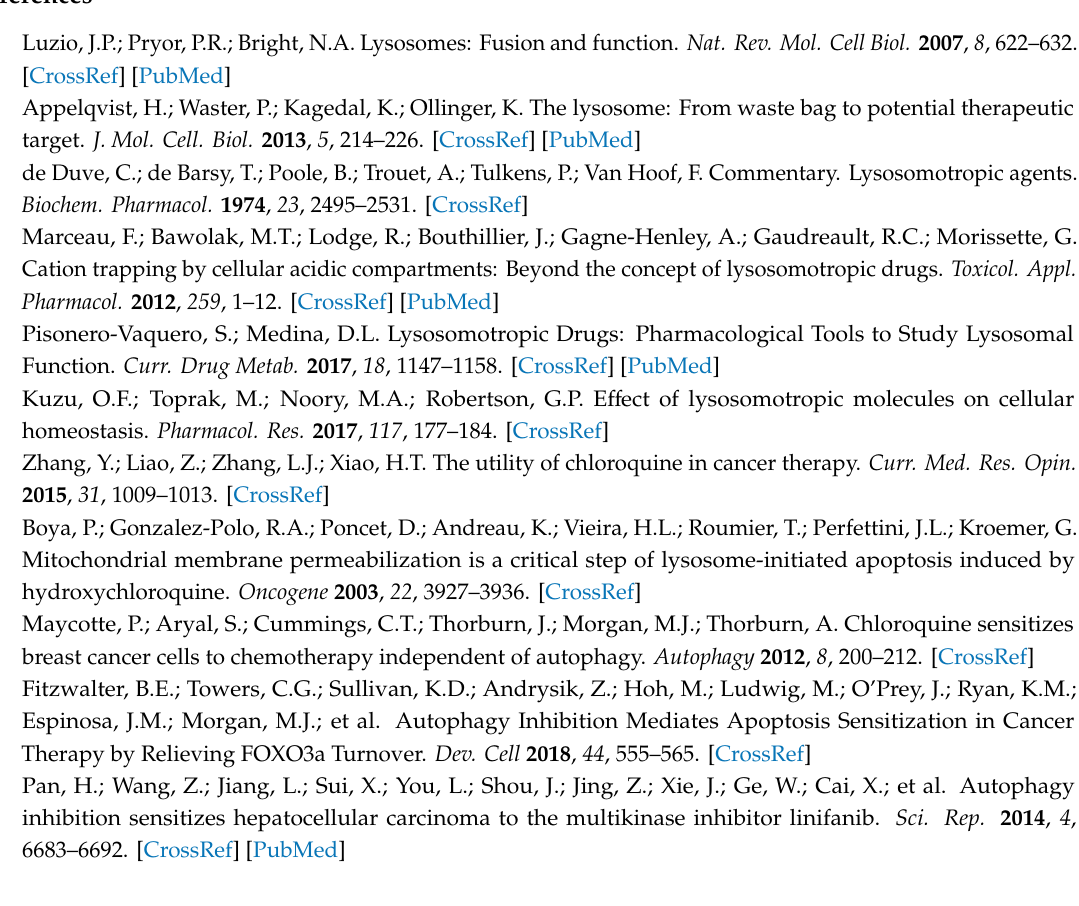
Figure S1: Analysis of expression and prognostic significance of survivin (BIRC5), DR5 (TNFRSF10B), USP9X and Cbl in renal clear cell carcinoma. Results were generated using the UCSC Xena browser based on data in TCGA. Figure S2. Uncropped western blots for Figure 1. Figure S3 Uncropped western blots for Figure 2. Figure S4. Uncropped western blots for Figure 3. Figure S5. Uncropped western blots for Figure 4. Figure S6. Uncropped western blots for Figure 5. Figure S7. Uncropped western blots for Figure 6. Figure S8. Uncropped western blots for Figure